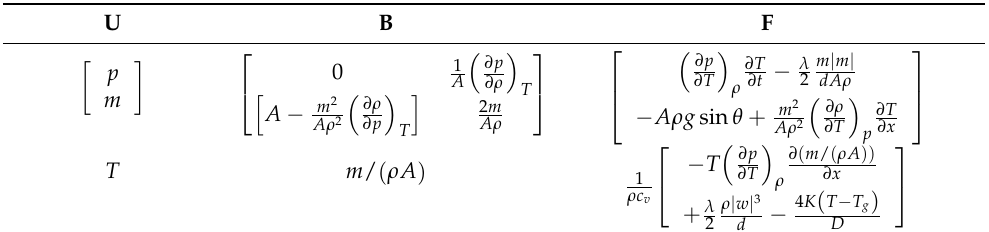
Table 1. Parameters in Equations (1) and